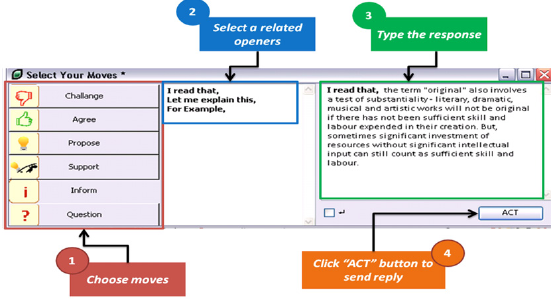
Figure 1. The typical design of Dia- Cog’s dialog game